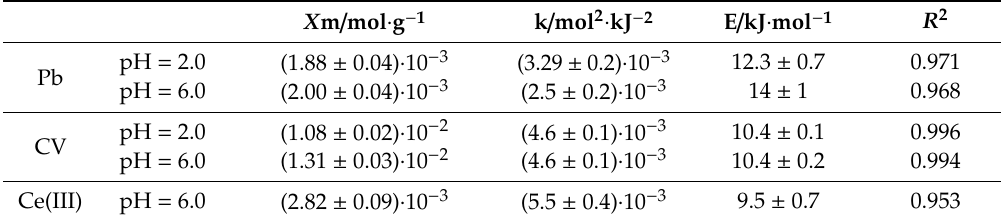
Table 3. Sorption DR parameters for the adsorption isotherms of the contaminants onto K10-Mt.